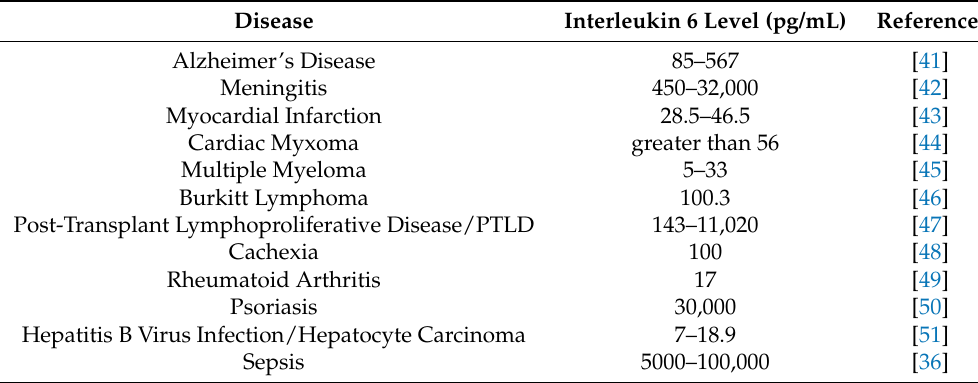
Table 1. Level of IL-6 in different pathological